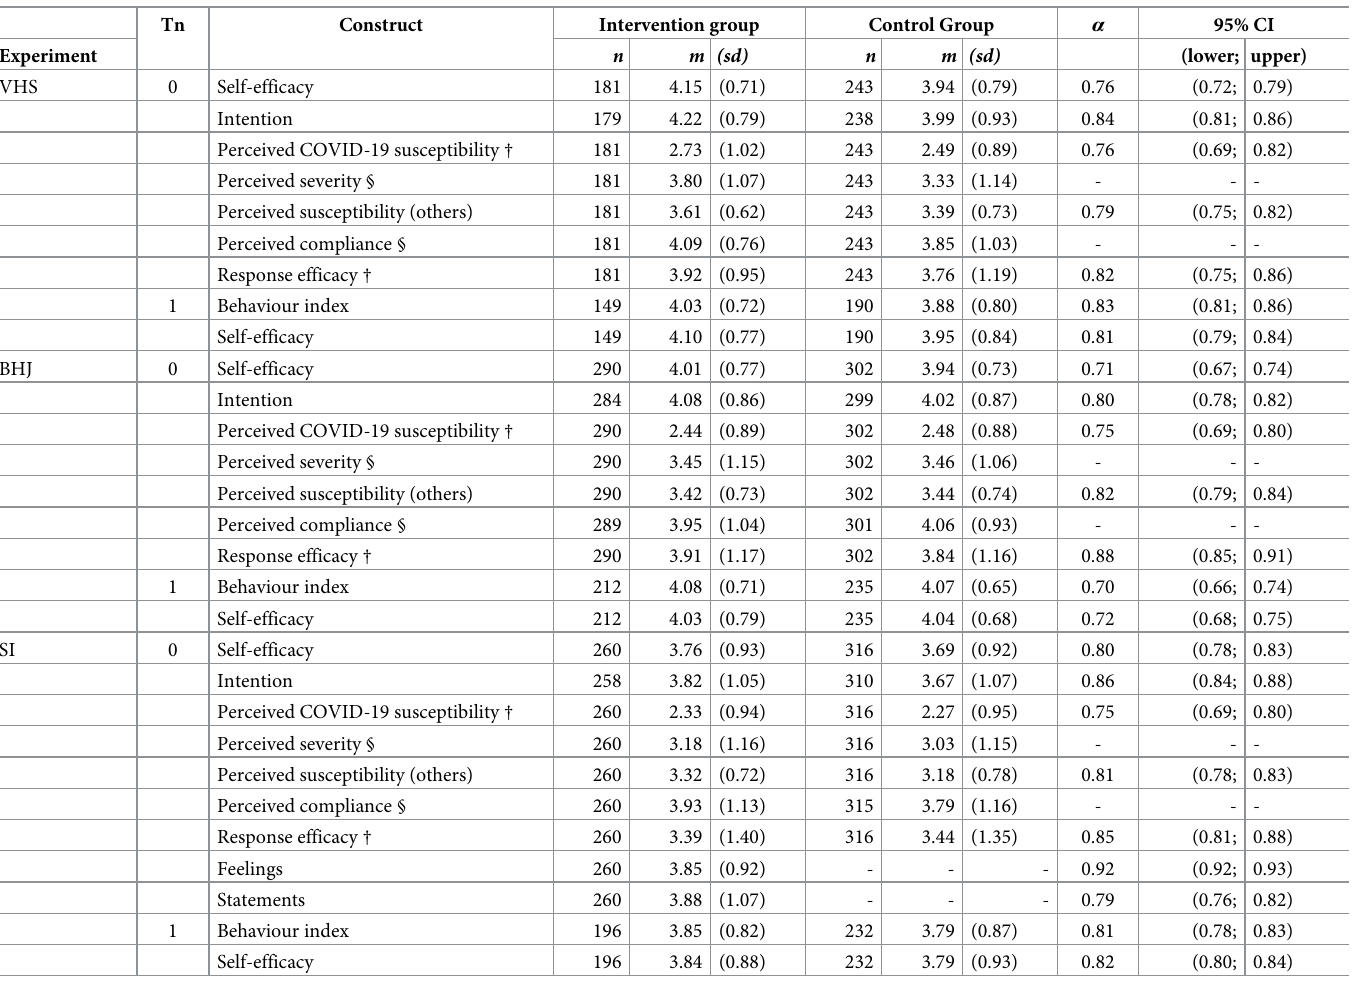
Table 2. Descriptive statistics and Cronbach’s coefficient alpha for measures in the three